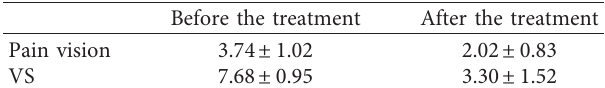
Table 1: Pain vision system measured pain ratio and VAS method before and after treatment. Before the treatment